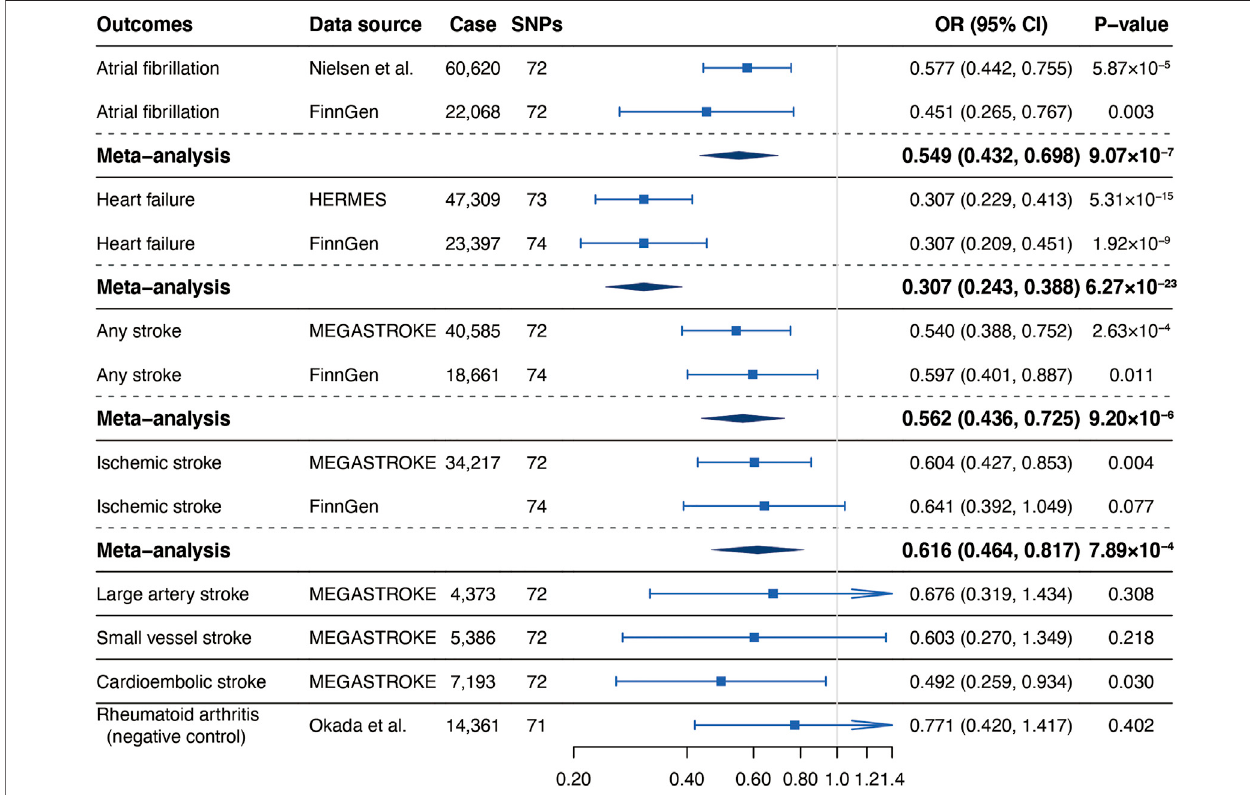
FIGURE 1 | Associations of genetically predicted self-reported walking pace with risk of cardiovascular diseases. Abbreviations: SNPs, single nucleotide polymorphisms; OR, odds ratio; CI, con fi dence interval; HERMES, Heart Failure Molecular Epidemiology for Therapeutic Targets.